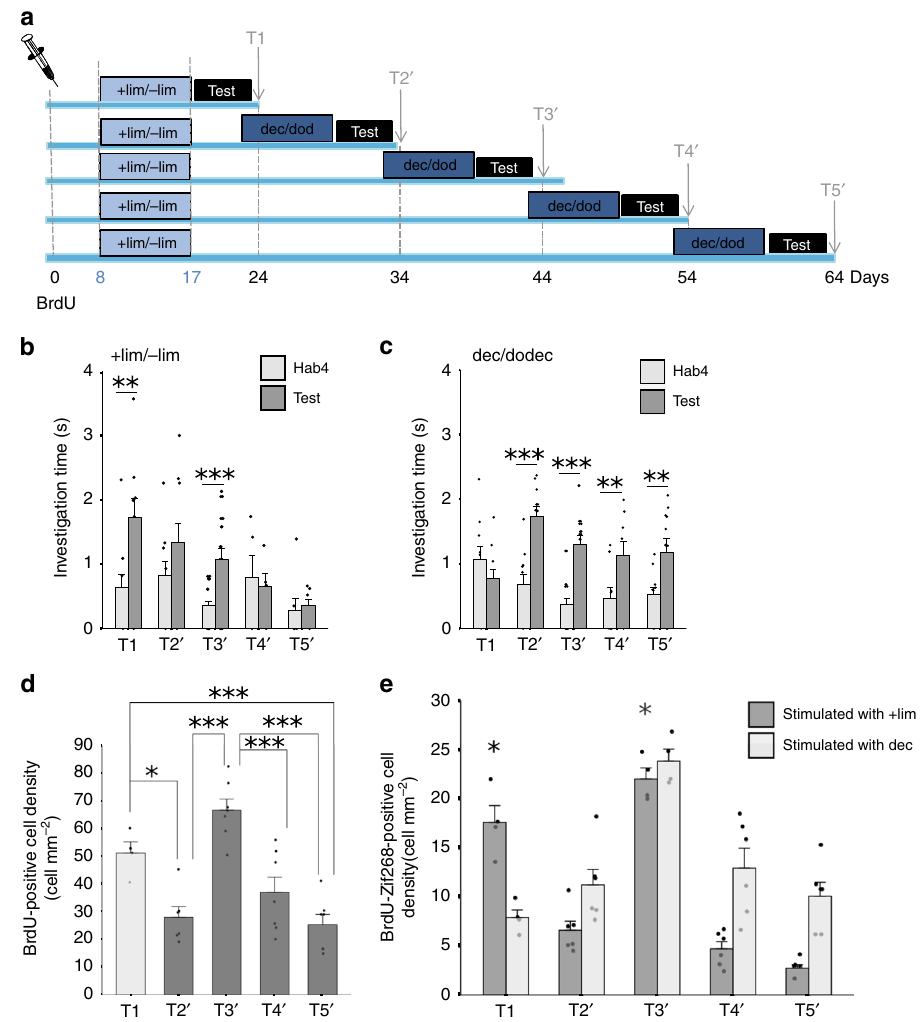
Fig. 2 Time between learning sessions has a critical impact on memory. a Experimental design. The groups differed by the interval between the two enrichment periods: 4, 14, 24 or 34 days separating the two enrichments. b , c Behavioral results. b Discrimination between + lim/ − lim. Groups T1 and T3 ′ discriminate. No discrimination is observed for the other groups (T2 ′ , T4 ′ , T5 ′ ) (T1 n = 11; T2 ’ n = 11; T3 ′ n = 11; T4 ′ n = 6; T5 ′ n = 7) t -test, ** p <